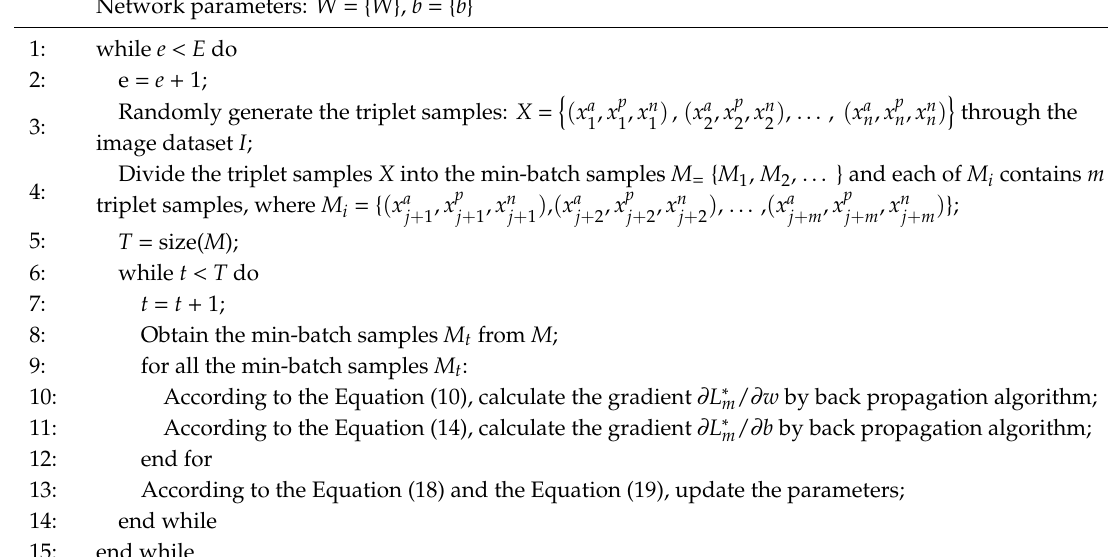
p p p ) , ( x a ) , . . . , ( x a ) } through , x , x n , x , x n , x , x n n n n 2 2 2 1 1 1 p ) , , x , x n j + 1 j + 1 j + 1